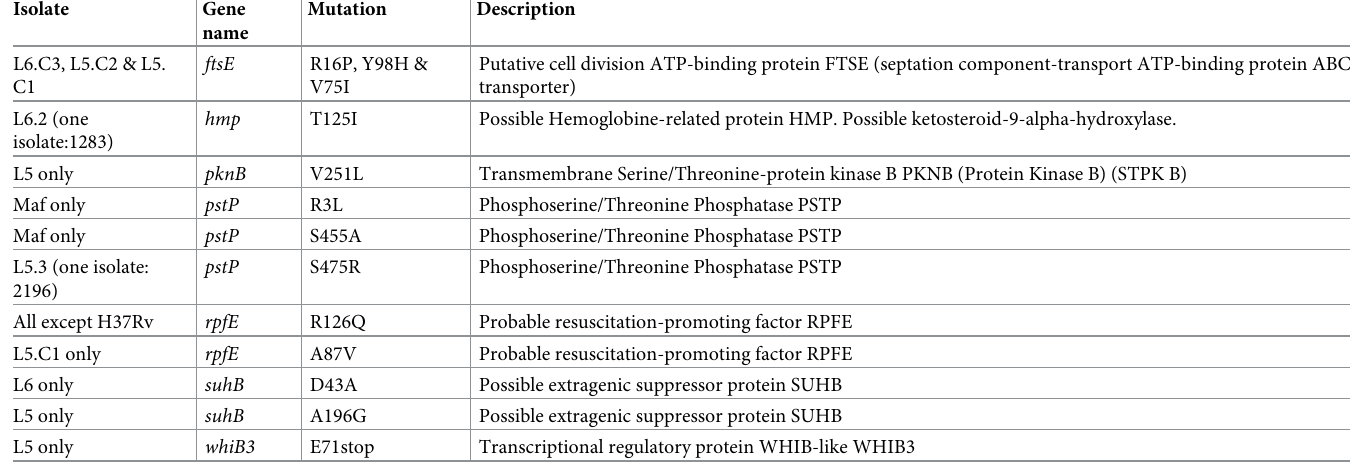
Table 2. Mutational analysis of genes that may be associated with growth rate. Isolate